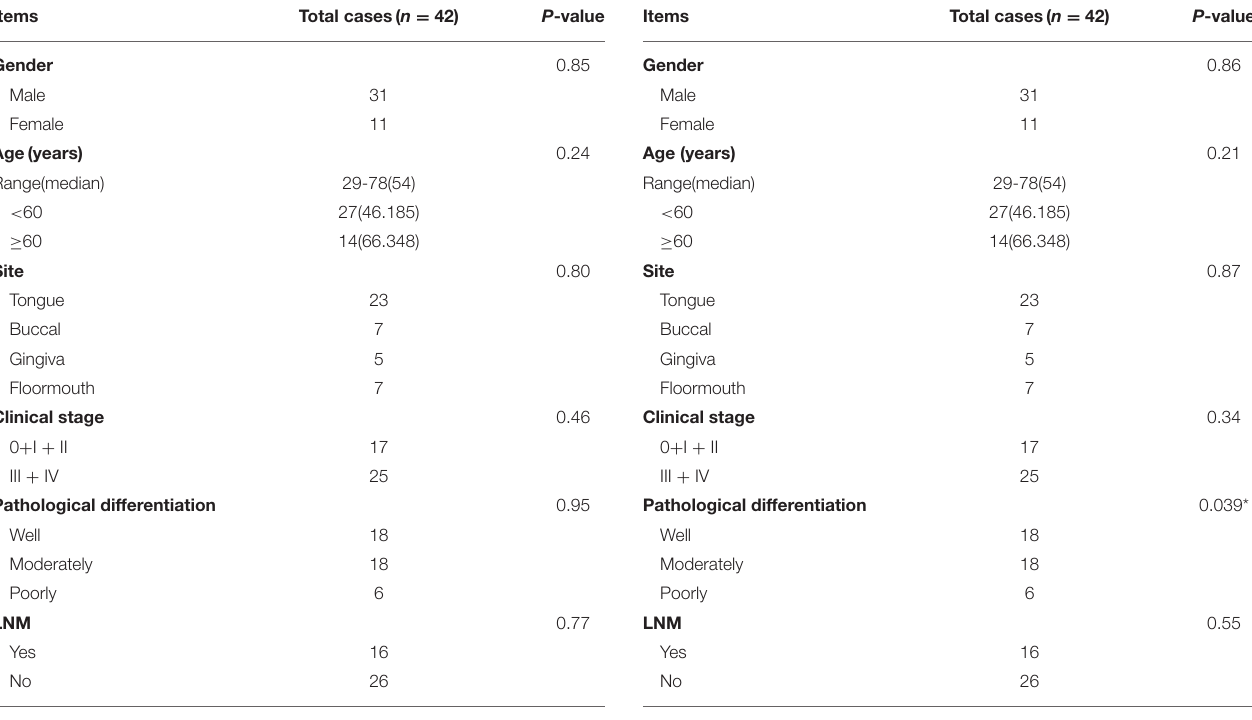
TABLE 3 | Correlation between hsa_circ_006371 expression and clinicopathological characteristics in 42 oral squamous cell carcinoma patients.